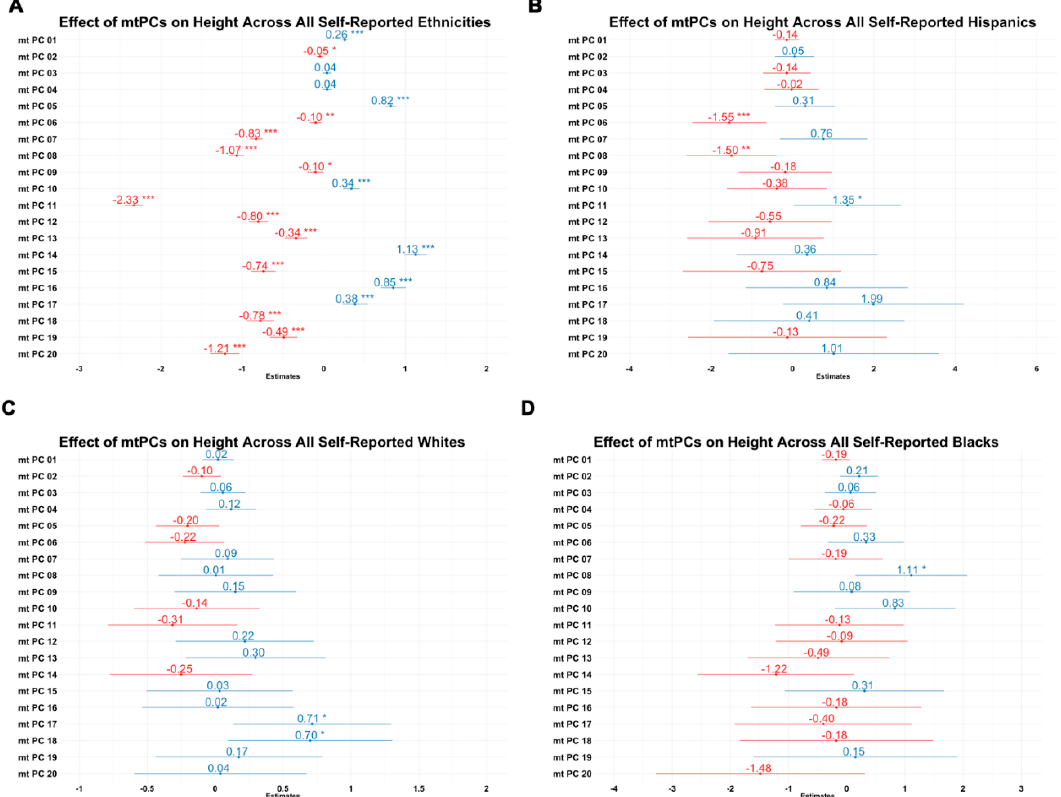
Figure 5. Effects of 20 mitochondrial principal components on height (centimeters) in inter-ethnic and intra-ethnic samples. ( A ) Combined analysis; ( B ) Hispanic analysis; ( C ) White analysis; ( D ) Black analysis. X axes are the coefficient estimate for mitochondrial principal component number (Y axes). * p < 0.05; ** p < 0.01; *** p < 0.001.